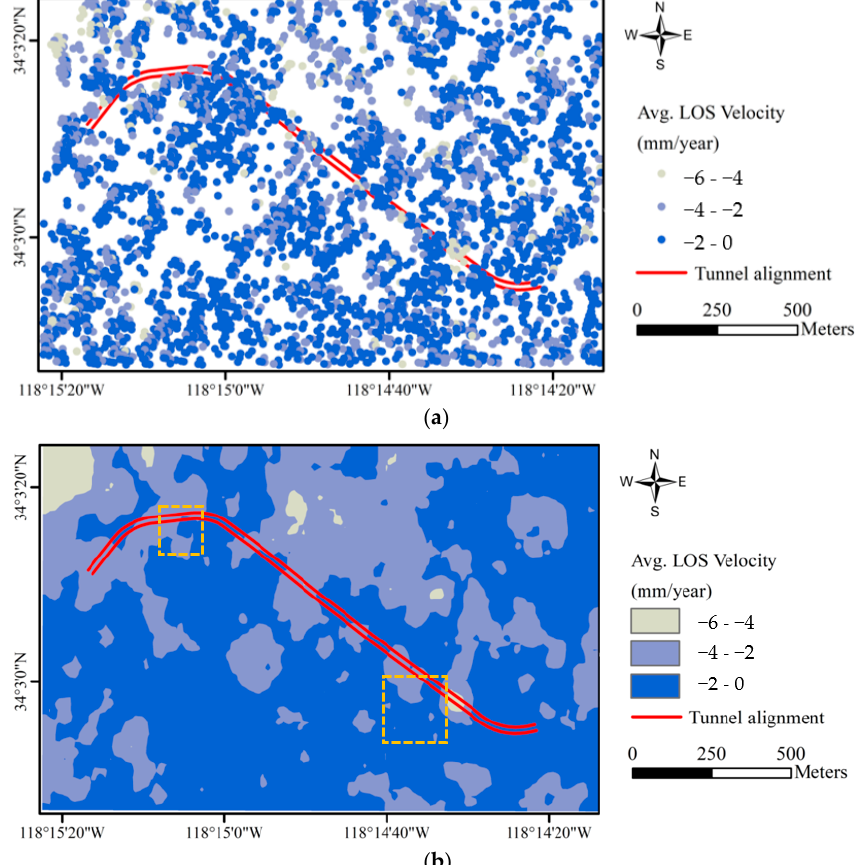
13 of 18 Figure 8. Average vertical settlement map along the twin-tunnel alignment. 5.2. Ground Subsidence before Tunneling InSAR data can provide valuable ground displacement behavior information before and during tunneling operations. Therefore, in addition to mapping ground settlements